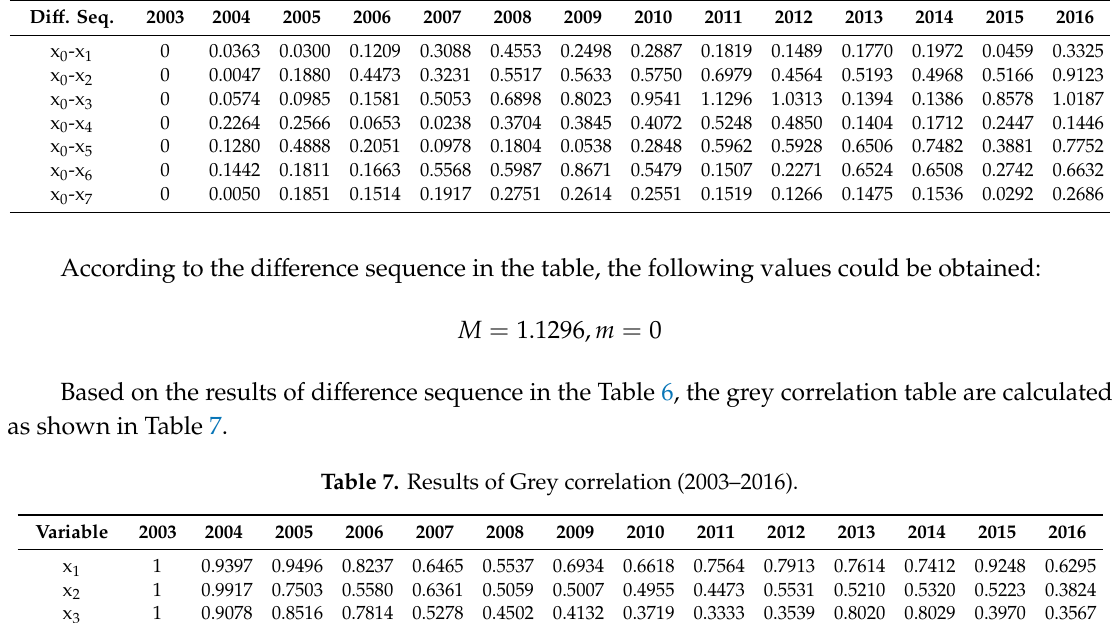
Table 6. Calculation results of di ff erential sequences through Grey correlation analysis (2003–2016). Di ff . Seq.